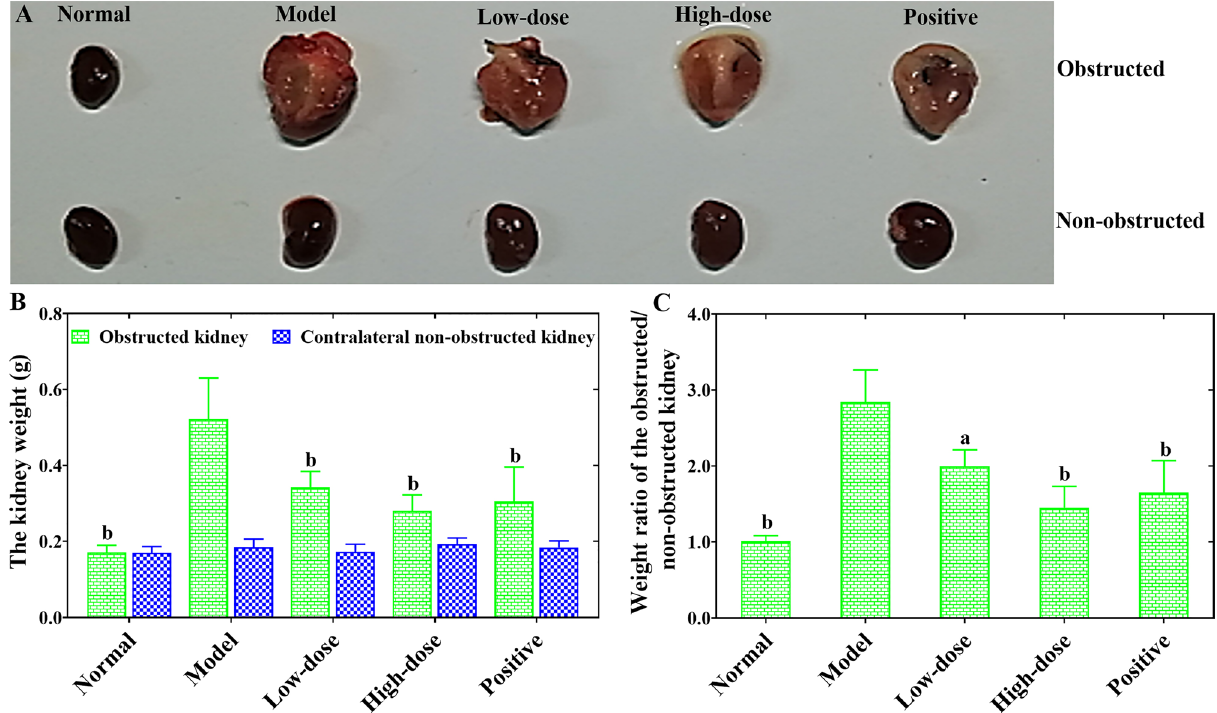
Figure 2. The effects of COS on the swelling and weight of the obstructed kidney in UUO-induced RF mice. The representative morphological images of the obstructed and contralateral non-obstructed kidney tissue from each group mice ( A ). Weight of kidney ( B ). Weight ratio of the obstructed/contralateral non-obstructed kidney from each group mice ( C ). All values are represented as mean ± SD (n = 10 in each group). Superscript letters a and b designate significant differences. a P < 0.05 compared with the model group. b P < 0.01 compared with the model